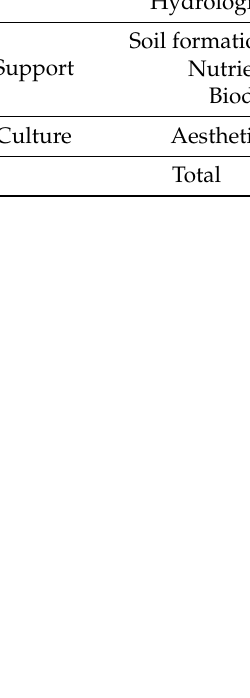
Table 5. Sensitivity coefficient resulting from the adjustment of the equivalent value